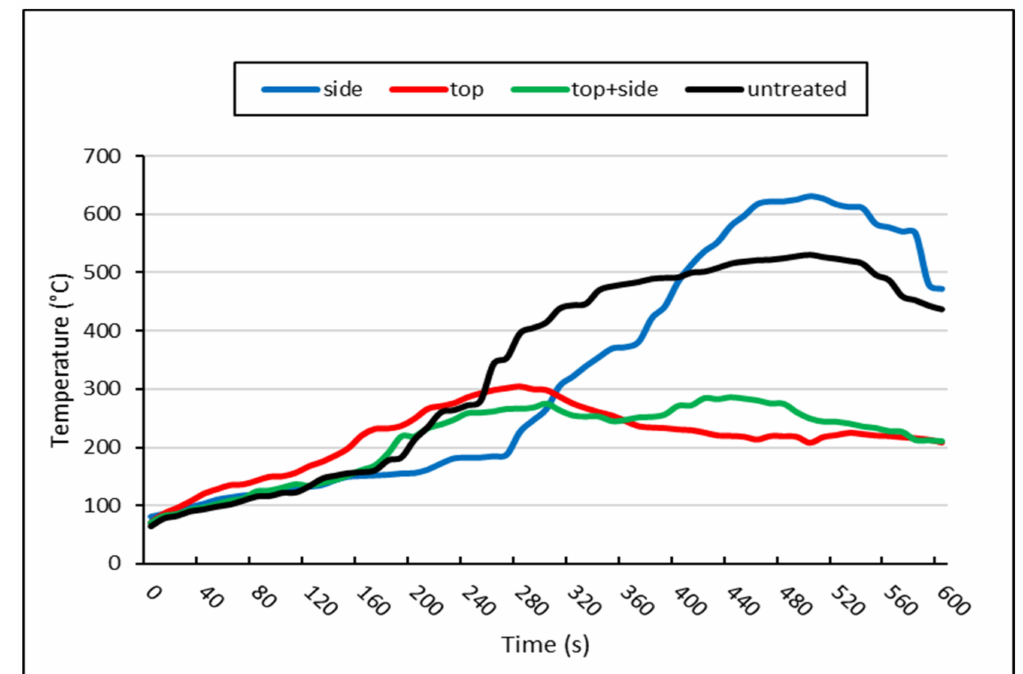
Figure 6. Temperature course of the samples on side